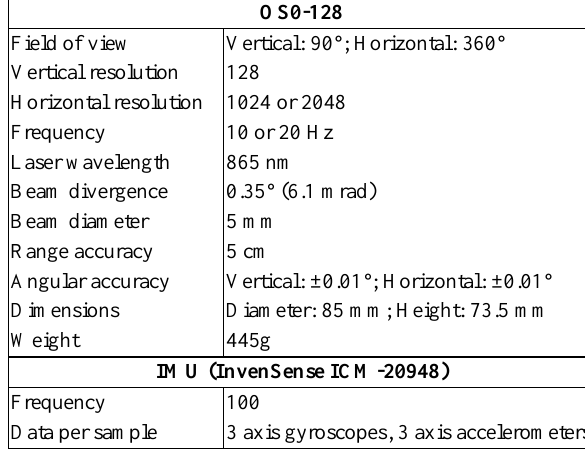
Table 1. Technical information of Ouster OS0 sensor with 128 channels (OS0-128) (OUSTER, 2020).